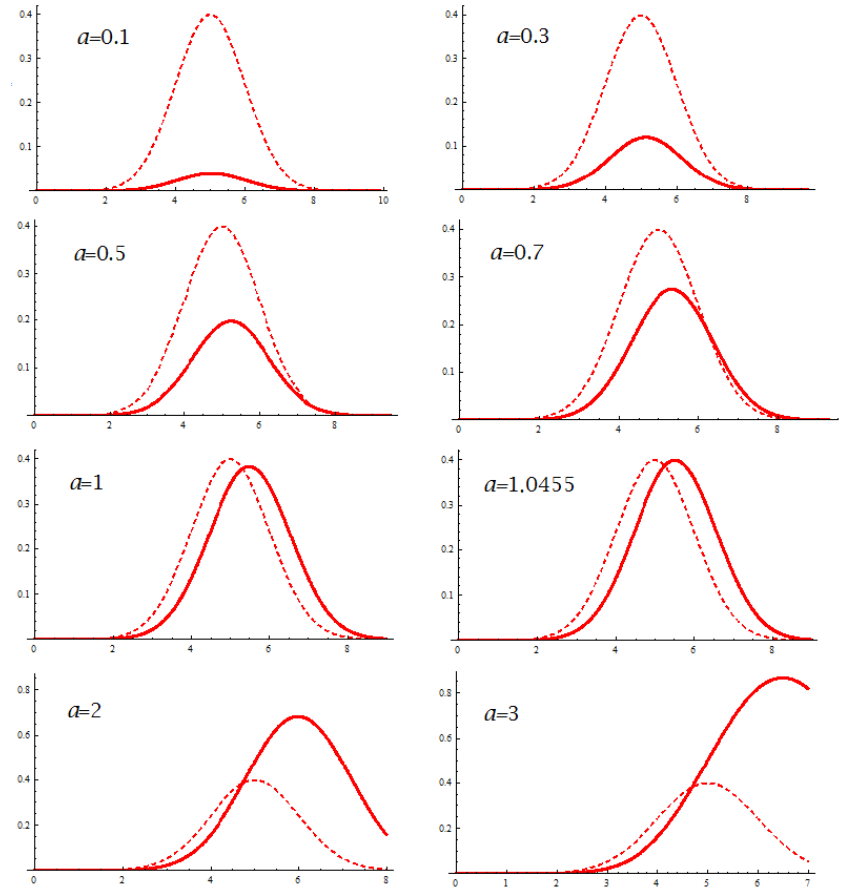
Figure 1. Graphs of functions λ ( t ) (dotted line), Λ ( t ) (solid